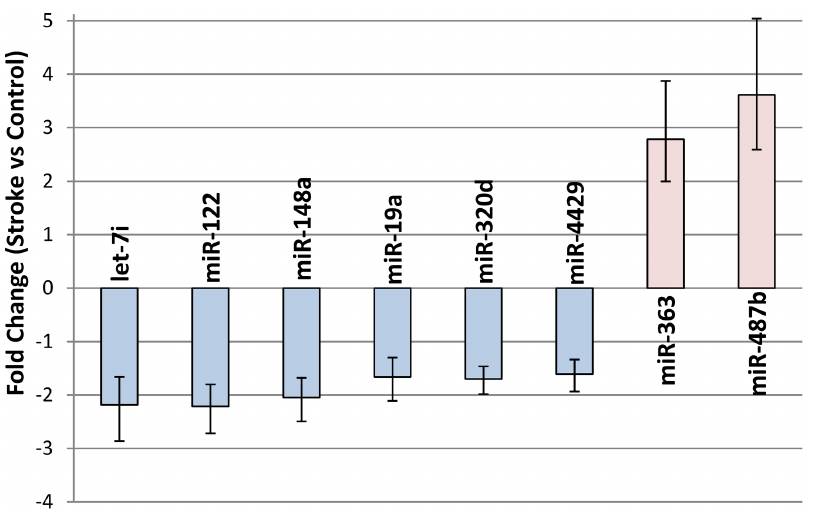
Figure 1. Fold change in microRNA that are significantly differentially expressed in patients with acute ischemic stroke compared to controls with vascular risk factors (FDR , 0.05). Error bars indicate standard error. Expression determined by qRT-PCR.